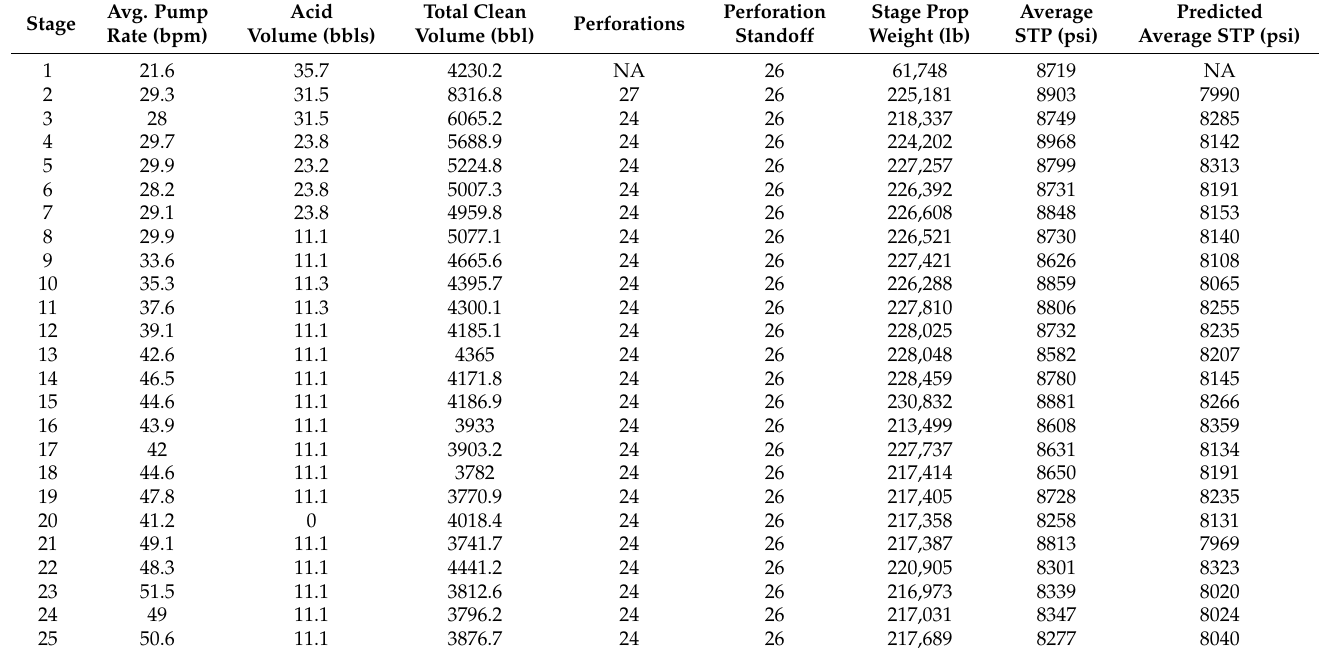
Table 5. Predicted average surface treating pressure for offset well using the model from this